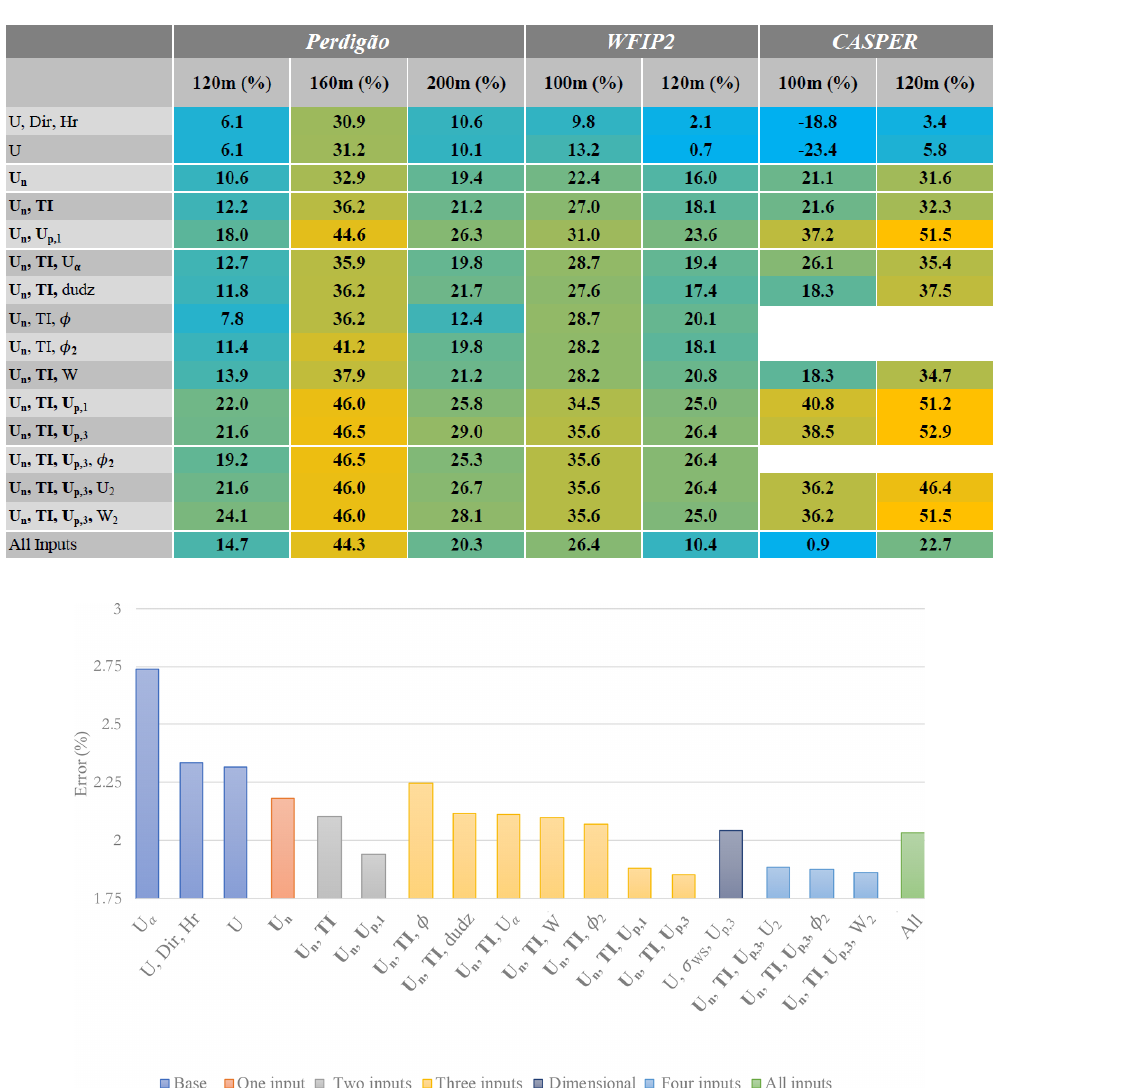
Table 2. ANN percent improvement over power-law extrapolation. Gold denotes the most improvement, while blue denotes less improvement or a decline in accuracy.